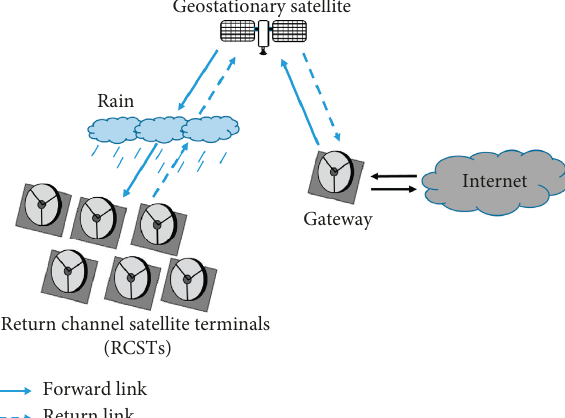
Figure 1: Reference